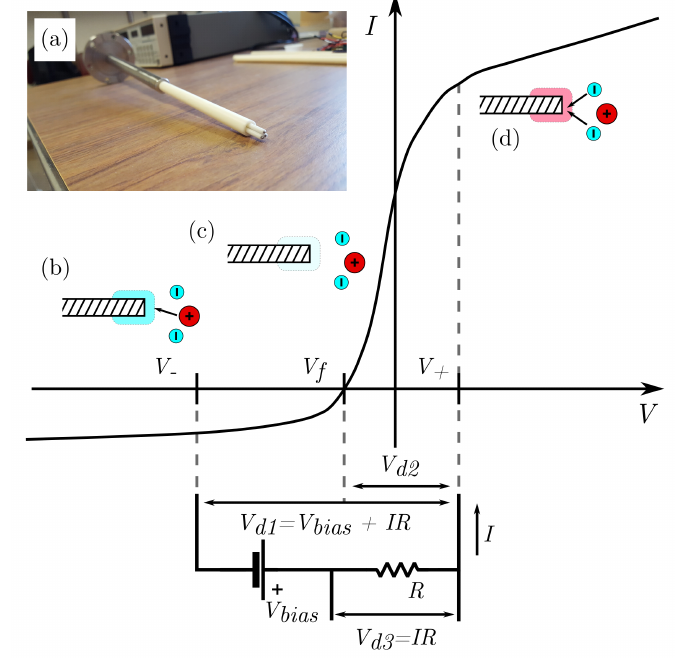
Figure 3. Overview of triple Langmuir probe direct display plasma density measurement. Three electrodes ( a ) are inserted into the plasma region. Two of the probes are biased with respect to one another using V bias to collect ion saturation current at V − ( b ) and electron saturation current at V + ( d ) where V + − V − = V d 1 . The final probe ( c ) is left at the plasma floating potential V f where no net current is collected. A simultaneous measurement of the potential difference V d 2 = V + − V f and the current through the biased probes (measured using shunt resistor voltage difference V d 3 ) yields a measurement of the plasma